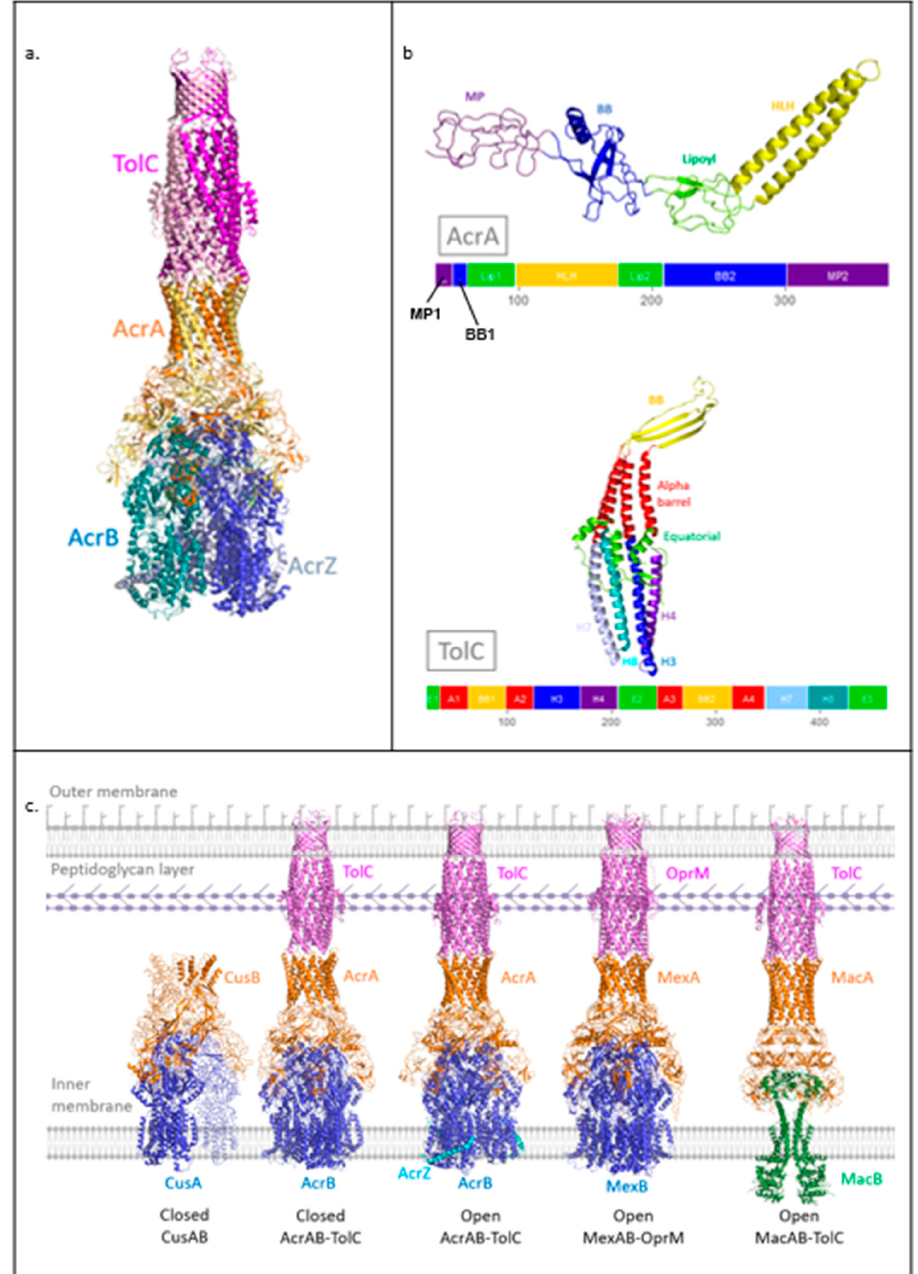
Figure 1. Structures of AcrAB-TolC and other drug efflux pump assemblies. ( a ) Transport state structure of AcrAB-TolC tripartite assembly (PDB: 5NG5). ( b ) Domain structure of AcrA and TolC protomers. For each protein, the top image shows the tertiary structure. The bottom image shows the primary sequence contribution to tertiary domain structure with equivalent colour scheme (5V5S). ( c ) High-resolution structures of RND family pump assemblies and of MacAB-TolC from the ABC transporter family (right to left: 3NE5, 5V5S, 5NG5, 6TA6, 5NIK). The CusAB trimer structure was generated from the PDB file of the monomeric unit through crystallographic symmetry using Coot [24,25]. The cell envelope includes a peptidoglycan layer and lipopolysaccharide in the outer leaflet of the outer membrane, both of which are represented schematically.